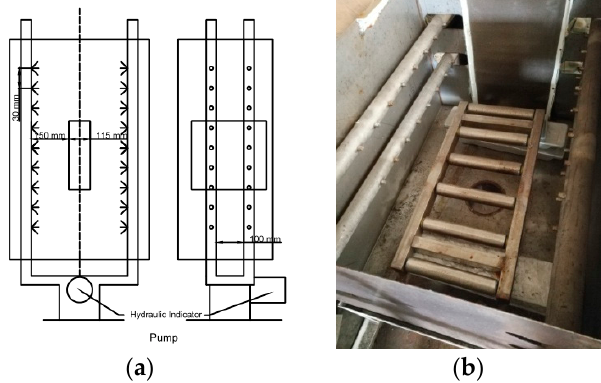
Figure 2. ( a ) Schematic and ( b ) photo of the spray quenching equipment.